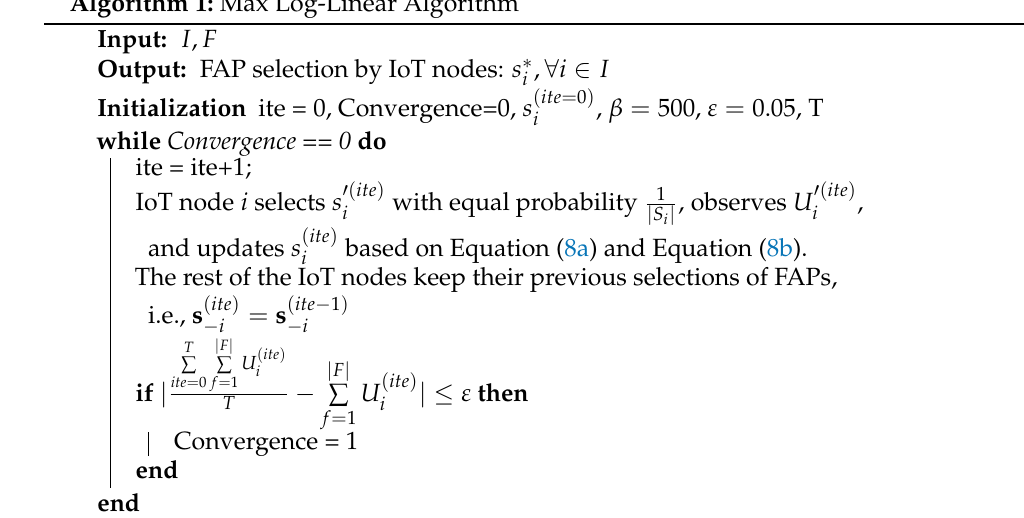
Algorithm 1: Max Log-Linear